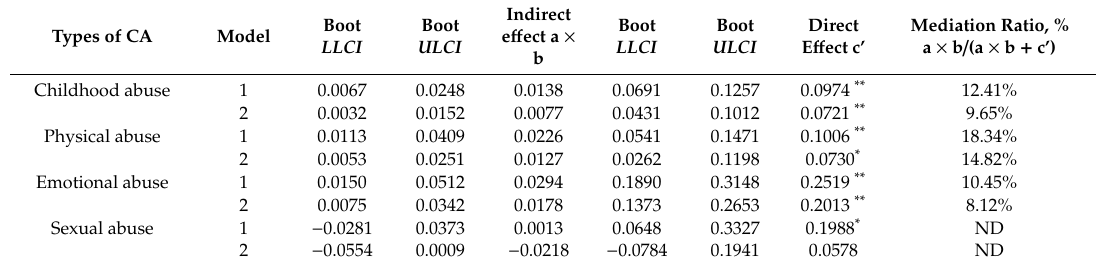
Table 4. Mediation e ff ects of social support between CA and NSSI in only-children.